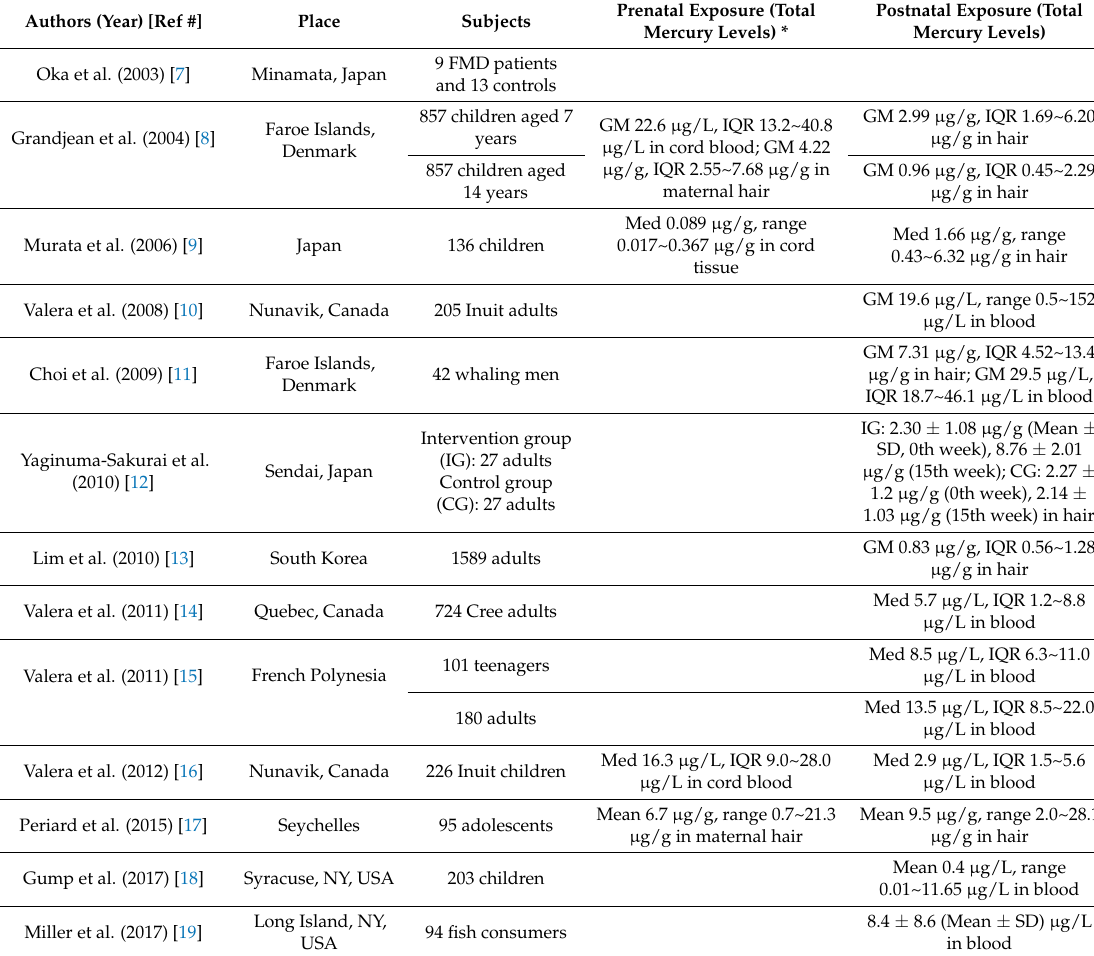
Table 1. Human studies addressing the effects of methylmercury exposure on heart rate